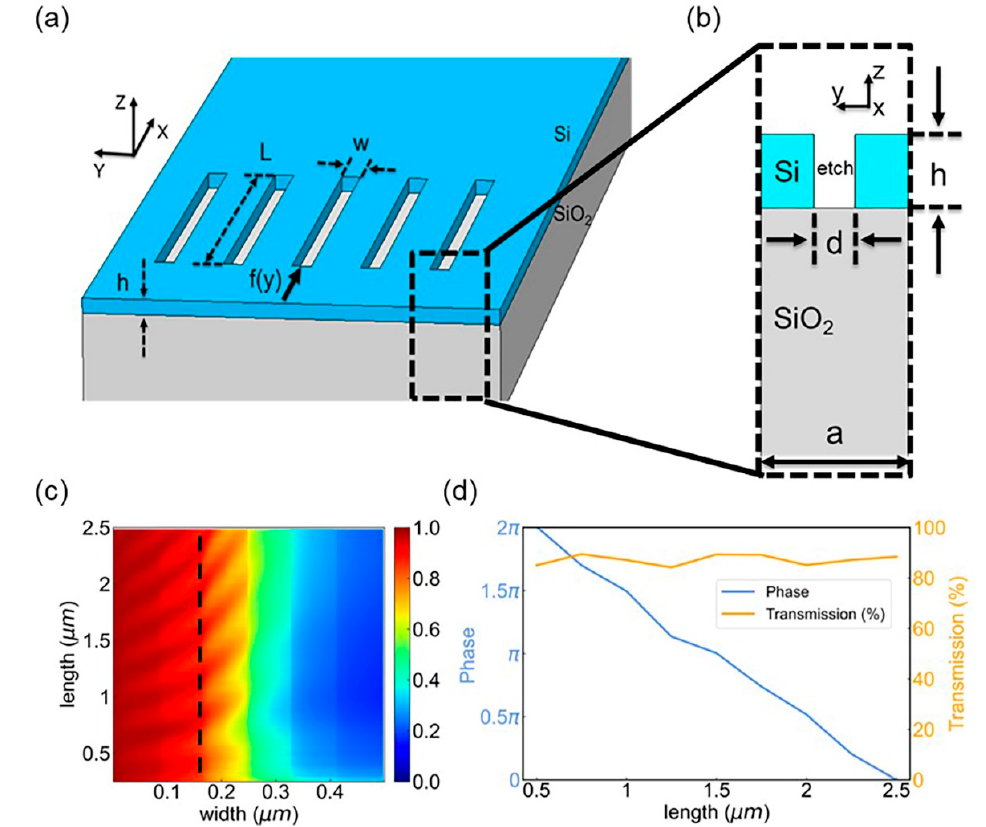
Figure 2. The design of the on-chip unit structure. ( a ) Schematic diagram of the three-dimensional structure of the on-chip metasurface-based device with wavelength λ = 1550 nm. w and L are the width and length of the etched slots, respectively. h is thickness of the Si layer, and f ( y ) is the incident signal. ( b ) Schematic diagram of the cross section of the device unit structure. The term h = 0.25 μ m denotes the thickness of the upper Si layer of the SOI and the etched slots. The slots are etched in the middle of the upper Si layer. ( c ) Calculated transmission results. The length of etched slot waveguide varies from 0.2 μ m to 2.5 μ m and the width varies from 0 to 0.5 μ m. The simulated transmission is a function of the width and length of the slot. The wavelength of the input light is 1550 nm (polarized in y-direction). ( d ) Calculated phase and transmission results. The simulated transmission and phase are related to the length of the slot. The length of the etched slot waveguide varies from 0.2 μ m to 2.5 μ m while the width of etched slot is fixed at w = 140 μ m. The slot waveguide with a length of 0.5 μ m to 2.5 μ m brings phase coverage from 0 to 2 π , while the transmittance is more than 80%.